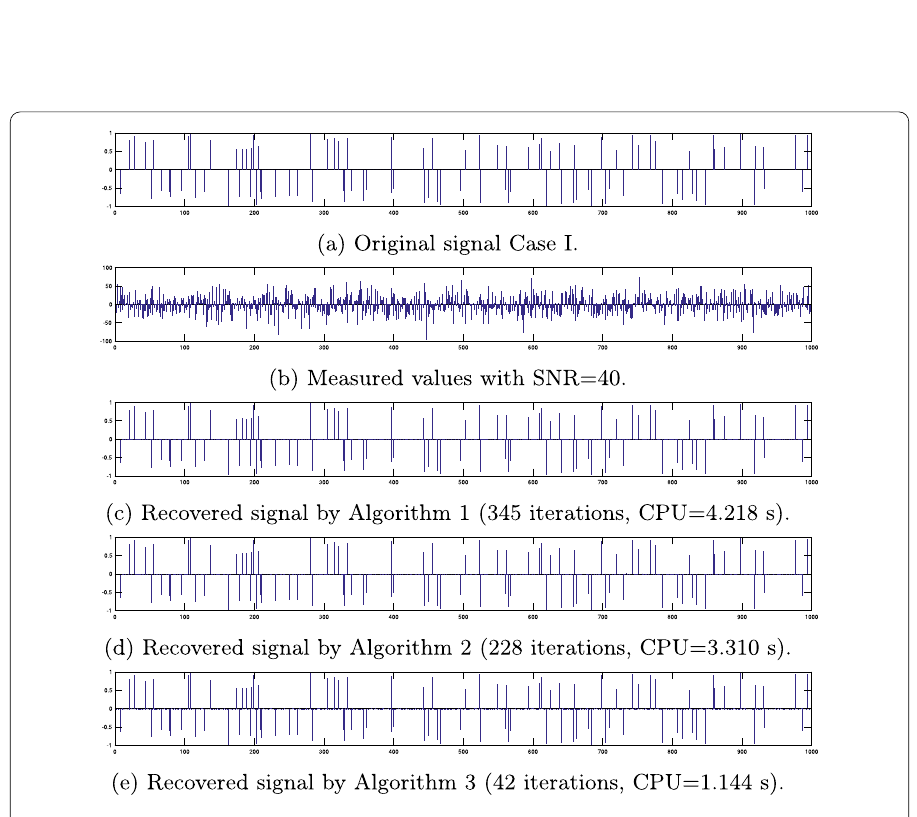
Figure 11 Computational results for Example 4.5 Case